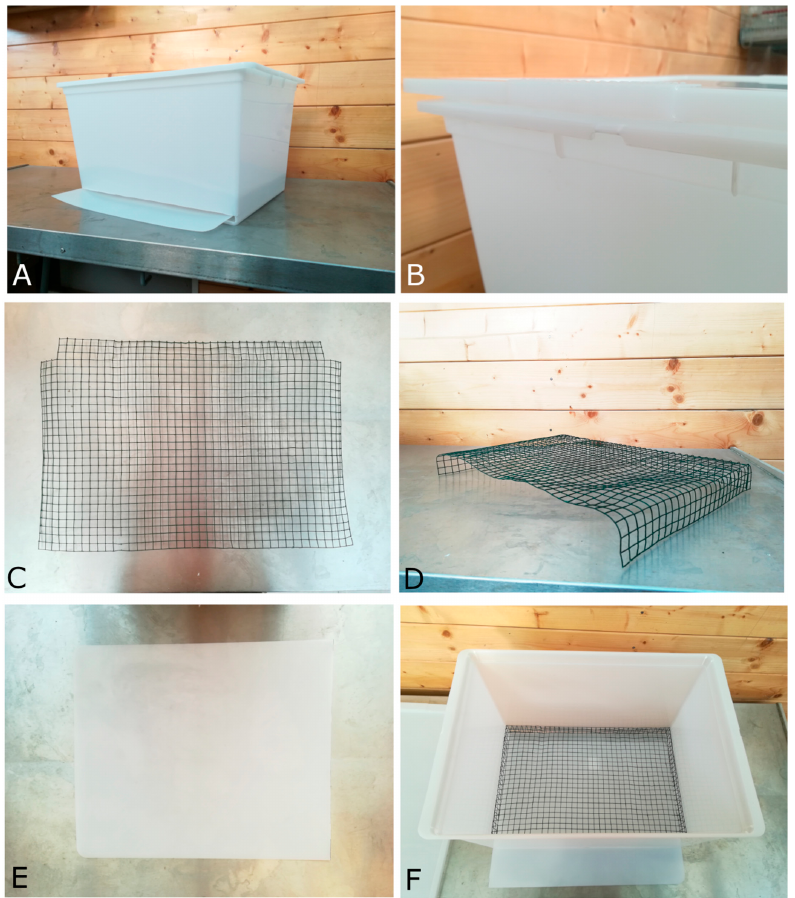
Figure 1. ( A ) The box complete and assembled with the all parts; ( B ) the detailed clip on the lids on the top are useful to close the box safely; ( C and D ) The flattened and folded grate that keep the